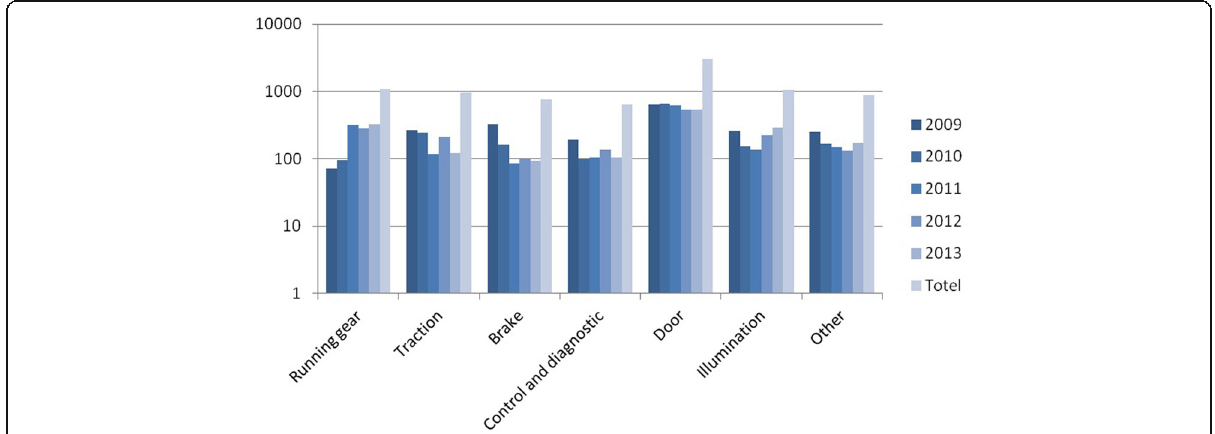
Fig. 2 Annual fault distribution diagram of key